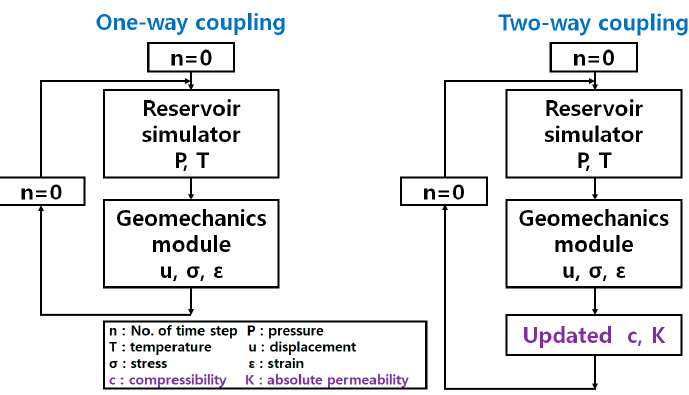
Figure 3. One-way and two-way coupling method.